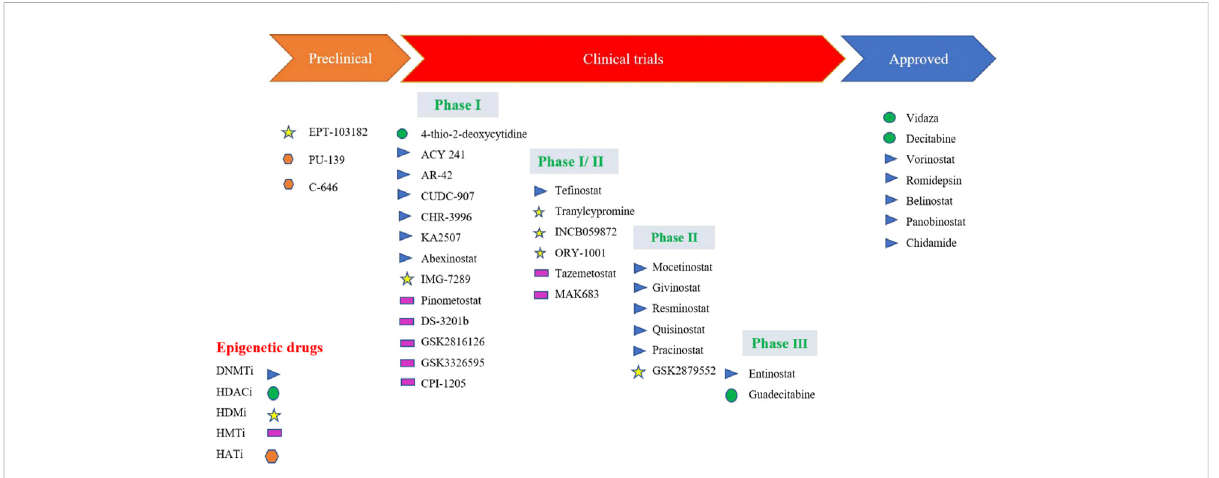
FIGURE 4 Epidrugs in preclinical and clinical trials for cancer therapy [Icons were created by Biorender.com]. (DNMTi - DNA methyl Transferase; HDACi — Histone deacetylase inhibitor; - HMTi -Histone methyltransferase inhibitors; HDMi- Histone demethylase inhibitors and HATi -Histone acetyltransferase